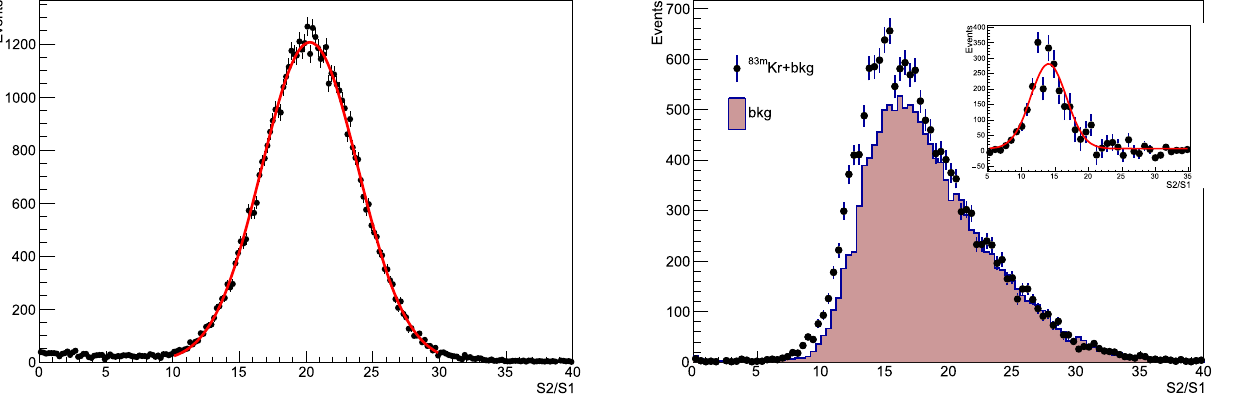
sideband (25–40PE) of the 83 m Kr peak, is shown as a solid histogram. The background-subtracted 83 m Kr signal distribution is shown in the inset, together with the asymmetric Gaussian function that best fits the data